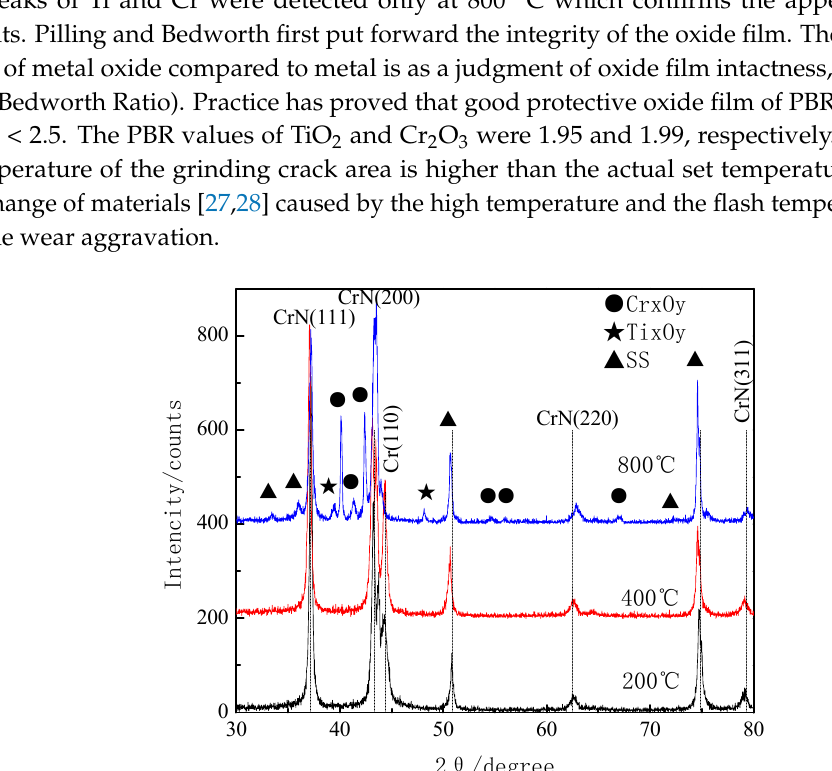
Figure 12. XRD patterns of Cr 38.7 Ti 3.7 B 6.4 N 51.2 composite film after wear test at different temperature.